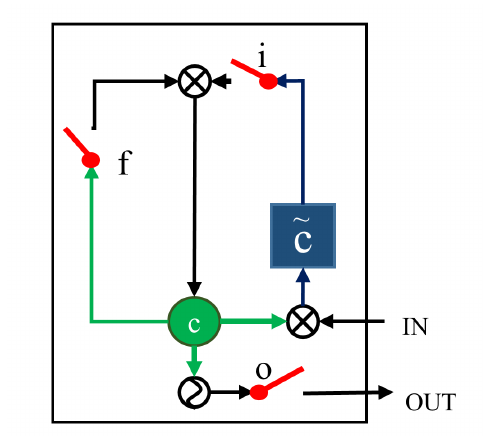
Figure 3. The architecture of LSTM module. Here, i is the input gate, f is the forget gate and o is the output gate. c is the cell state and (cid:101) C is the update cell.